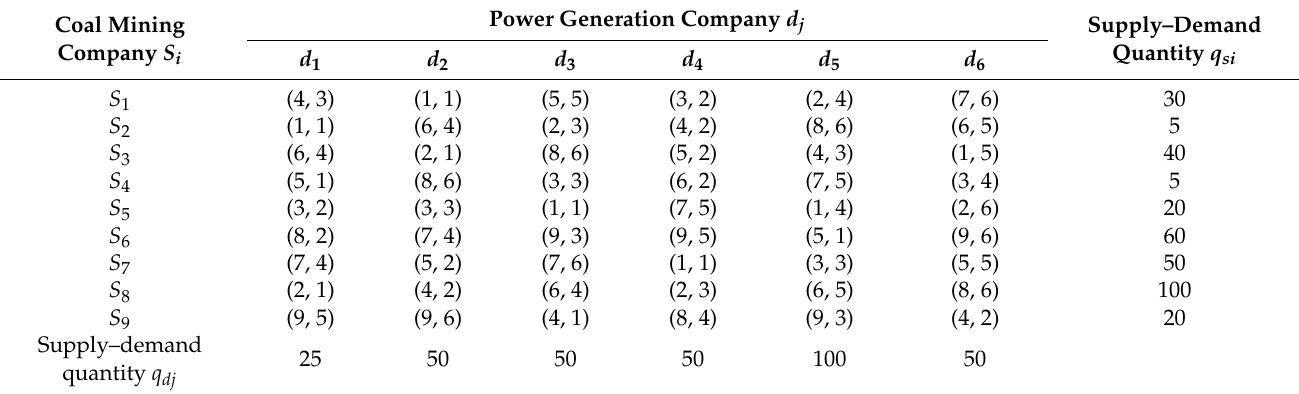
Table 1. Preference order and supply–demand quantity for